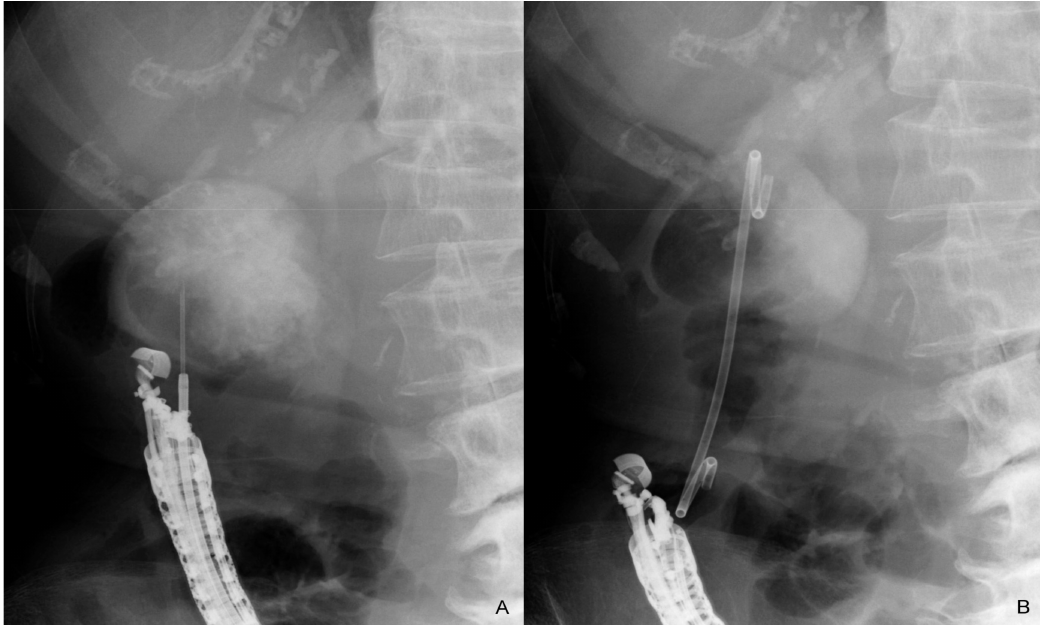
Figure 2. Endoscopic ultrasound-guided gallbladder drainage. After the gallbladder is punctured transduodenally ( A ), a guidewire is placed in the gallbladder. A 7 Fr double-pigtail plastic stent is placed after dilation of the fistula ( B ). The stent remains in place after the procedure without any stent exchange and